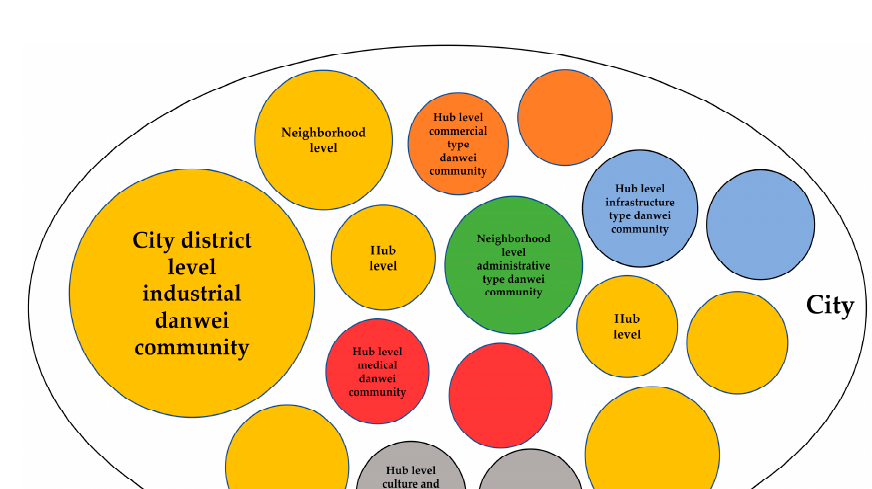
Figure 1. Two basic spatial patterns of the danwei community (adapted from [21]). Table 1. Main functional zoning of the danwei community. The space allocation planning for the cities in this period depended on the types and sizes of the danwei communities that were present [19]. As shown in Figure 2, Chinese cities are usually formed of numerous danwei communities of di ff erent types and sizes. These communities can be subdivided into industrial, administrative, commercial, medi- cal, infrastructural, cultural, and educational categories. They can also be divided, based on their size, into hub, neighborhood, city district, and city levels (see Table 2).